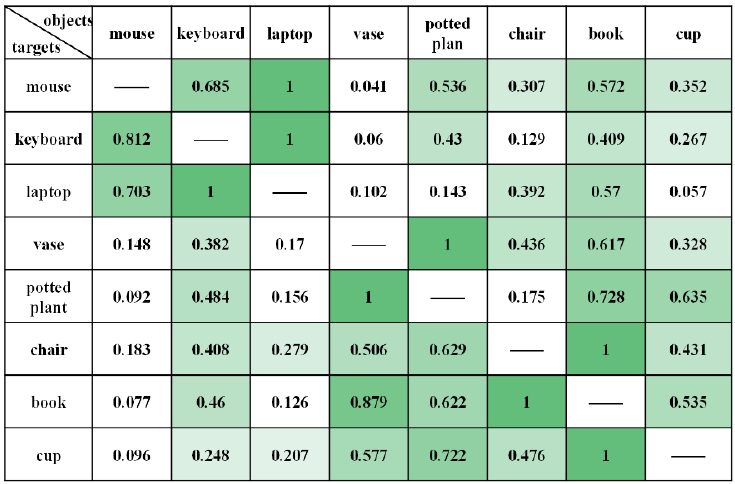
Figure 6. The semantic association model for the office places.